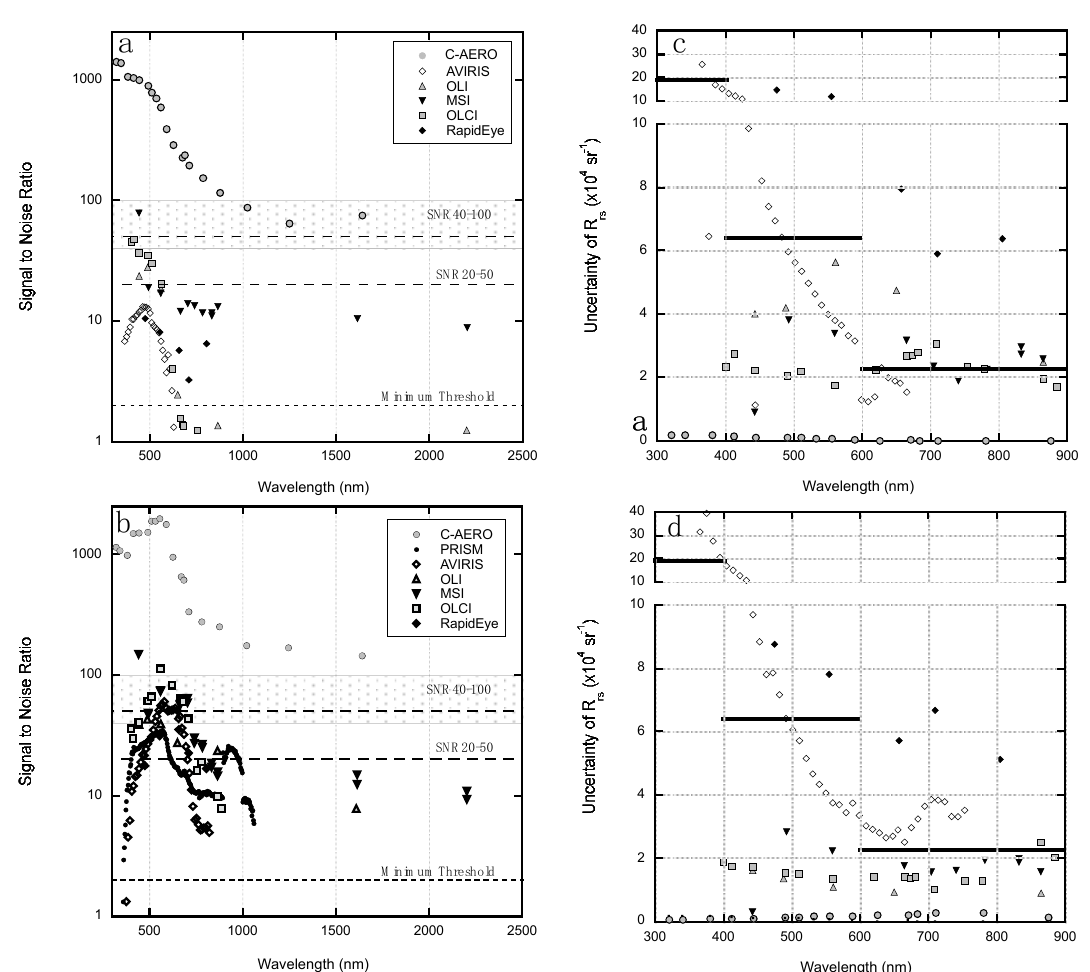
Figure 4. Signal-to-noise ratio (SNR) and uncertainty of R rs for dim and bright targets. ( a ) SNR for Lake Tahoe (dim target); ( b ) SNR for San Pablo bright targets; ( c ) corresponding uncertainty for Lake Tahoe; ( d ) uncertainty for bright targets. Symbols for panels (c,d) follow panels (a,b). The solid horizontal lines in panels (c,d) denote recommended uncertainty levels (values should be below the lines).